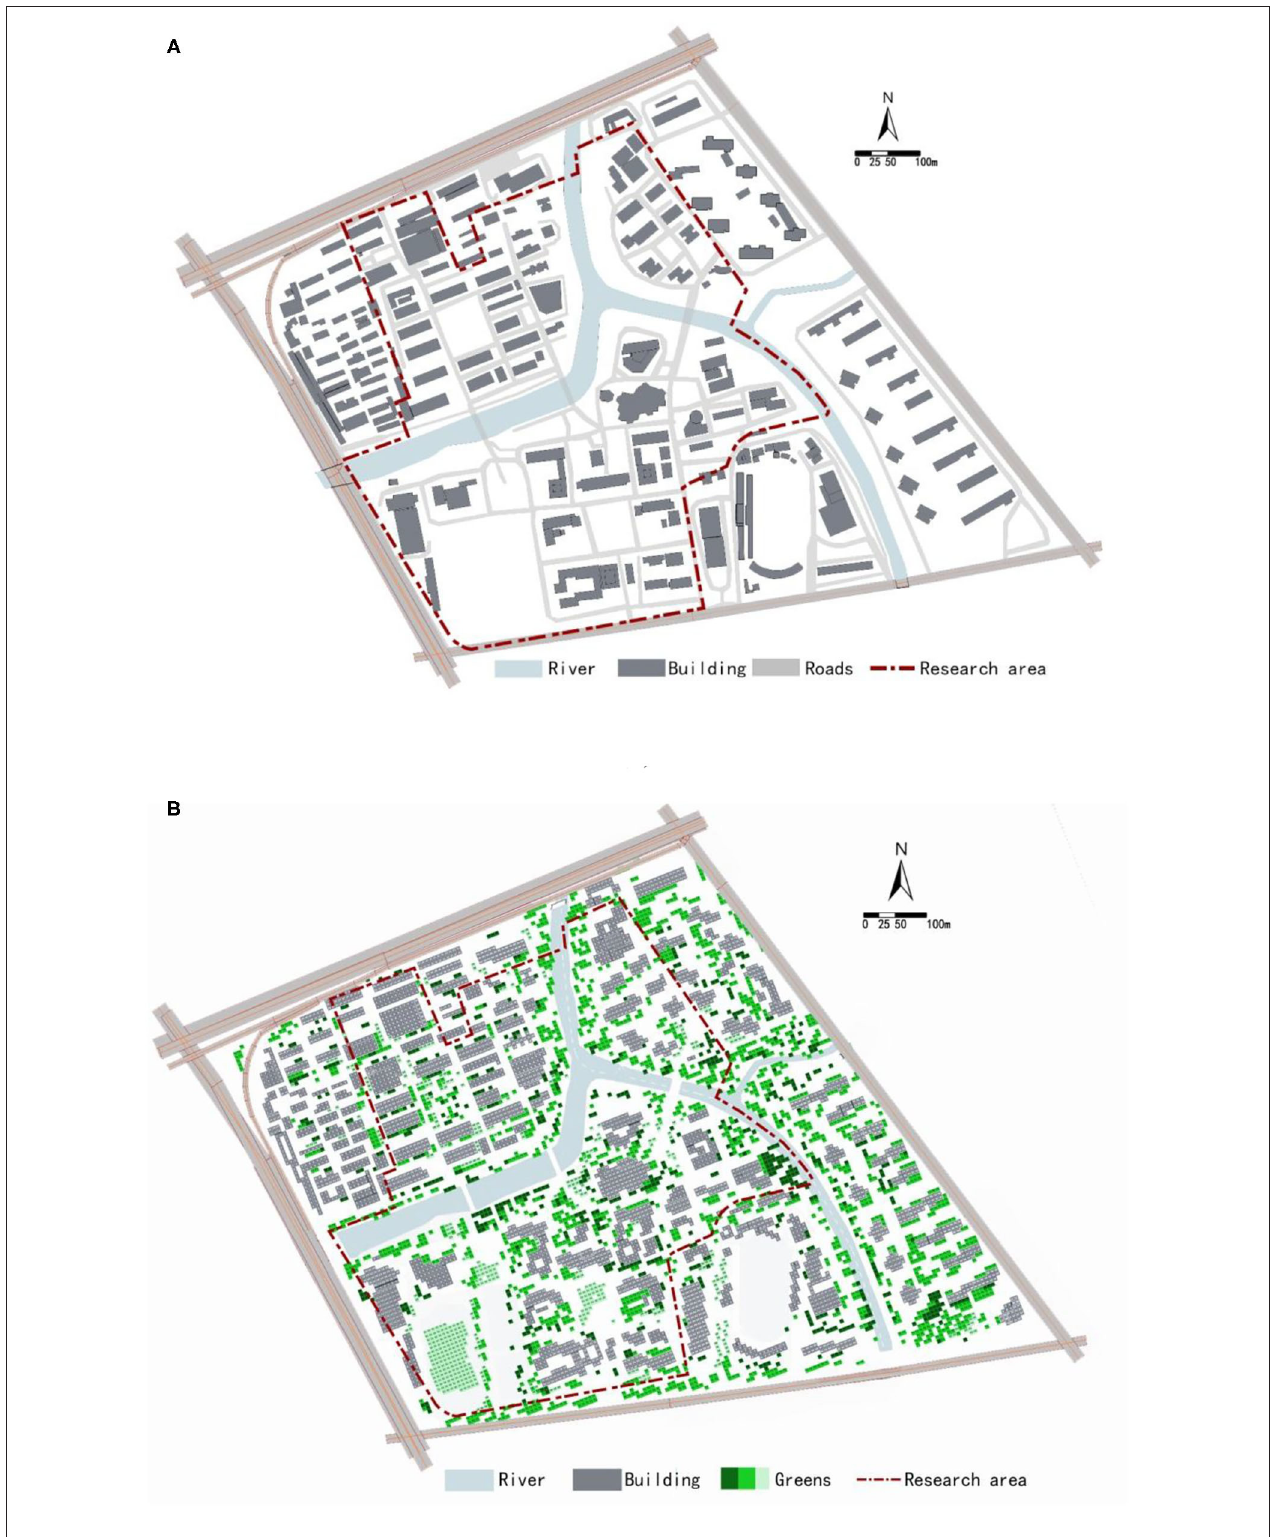
FIGURE 3 | Simulation models: (A) NoiseSystem model, (B) ENVI-met model.